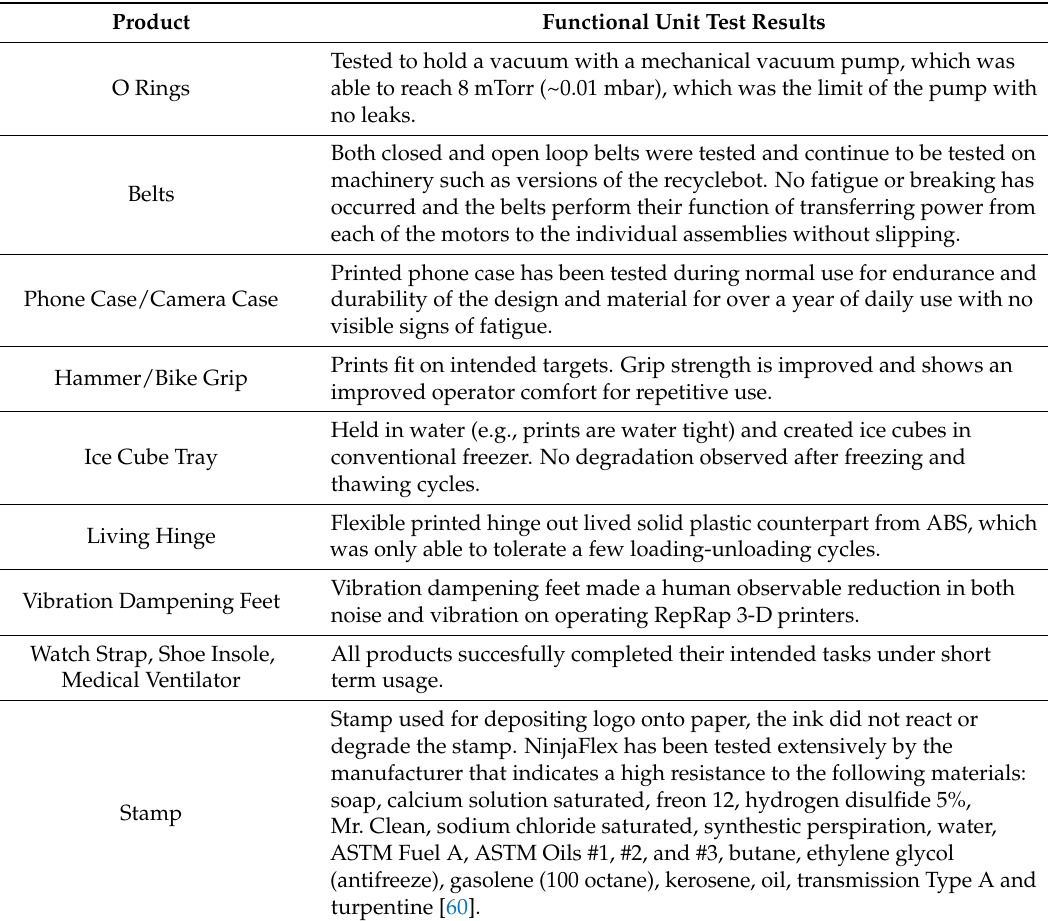
Table 5. The 3-D Printed Parts Functional Unit Tests